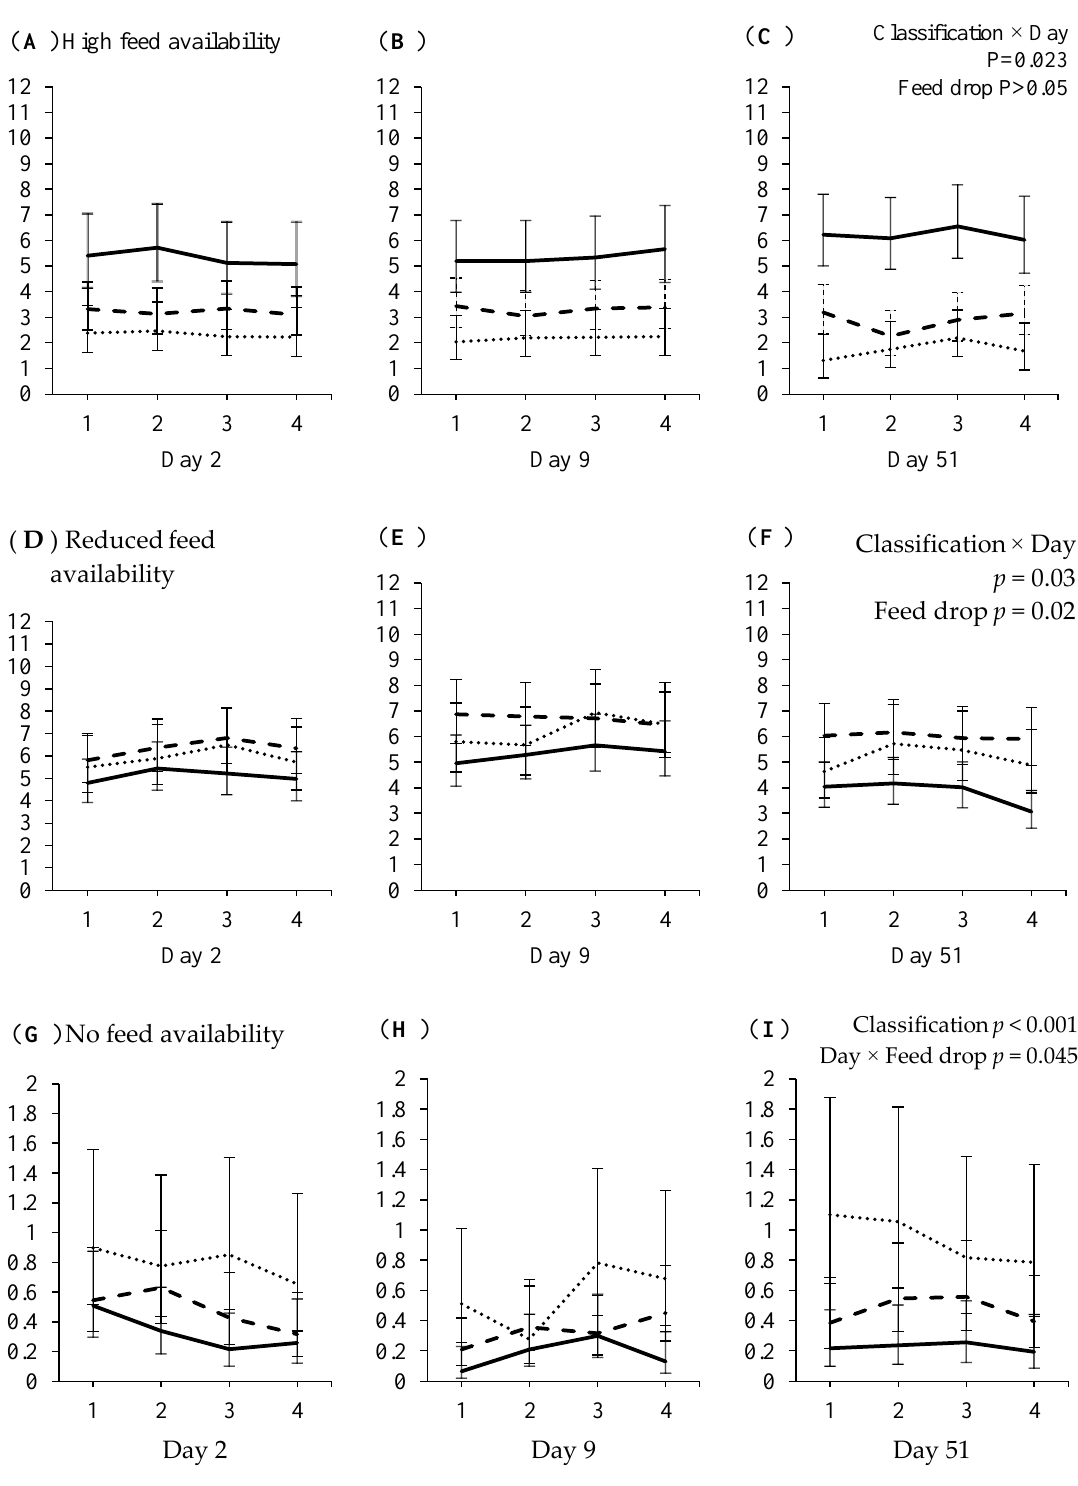
Figure 3. Gestation 2: The average number (±95% confidence interval) of times dominant ( ▬ ), subdominant (—) and submissive ( ··· ) sows were recorded showing feeding behavior (y-axis) in areas associated with high ( A – C ), reduced ( D – F ) or no ( G – I ) food availability, when fed over four feed drops (x-axis) on days 2, 9 and 51 post-mixing.